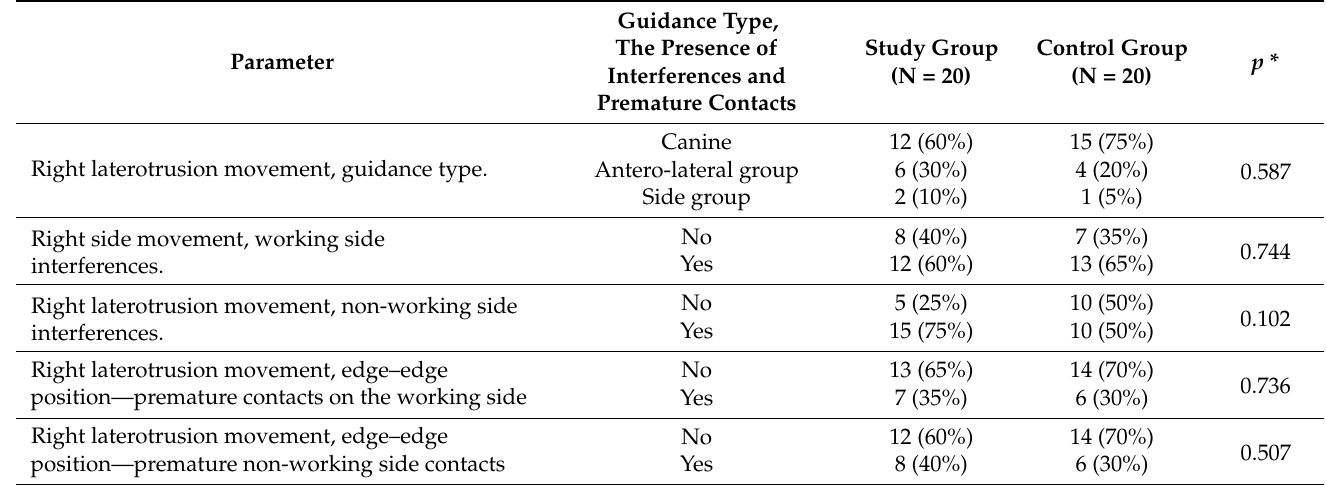
Table 12. Evaluation of the right laterotrusion movement according to the type of guidance, the presence of working and non-working interferences, and premature contacts. Guidance Type, Study Group Control Group The Presence of Parameter (N = 20) (N = 20) Interferences and Premature Contacts